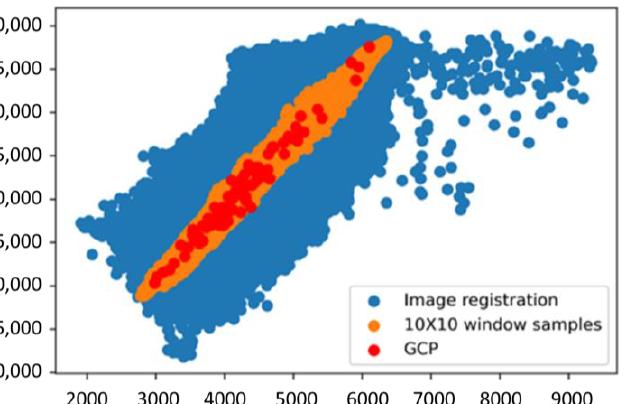
Figure 3. Uncertainty in collecting data. The accuracy decreases in the order of GCP, window sampler, and image registration.